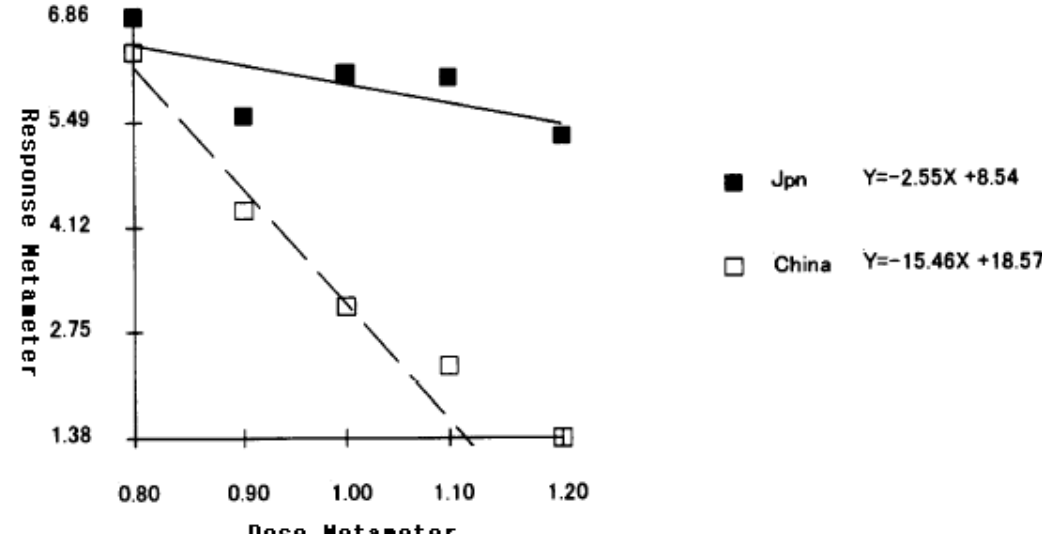
Figure 3: Median anti-lethal toxin effective dose (ED Jiangzhe Agkistrodon halys (China) antivenoms against 89.4 µg Agkistrodon halys ) intraperitoneally administered to venom (2.2 x LD 50